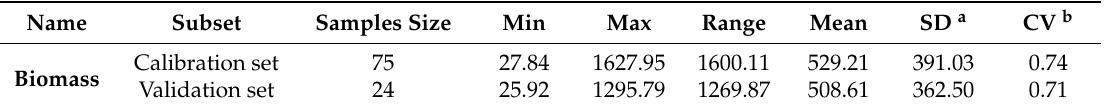
Table 2. Summary statistics of the measured biomass (g/m 2 ) of winter oilseed rape in the Deqing district.